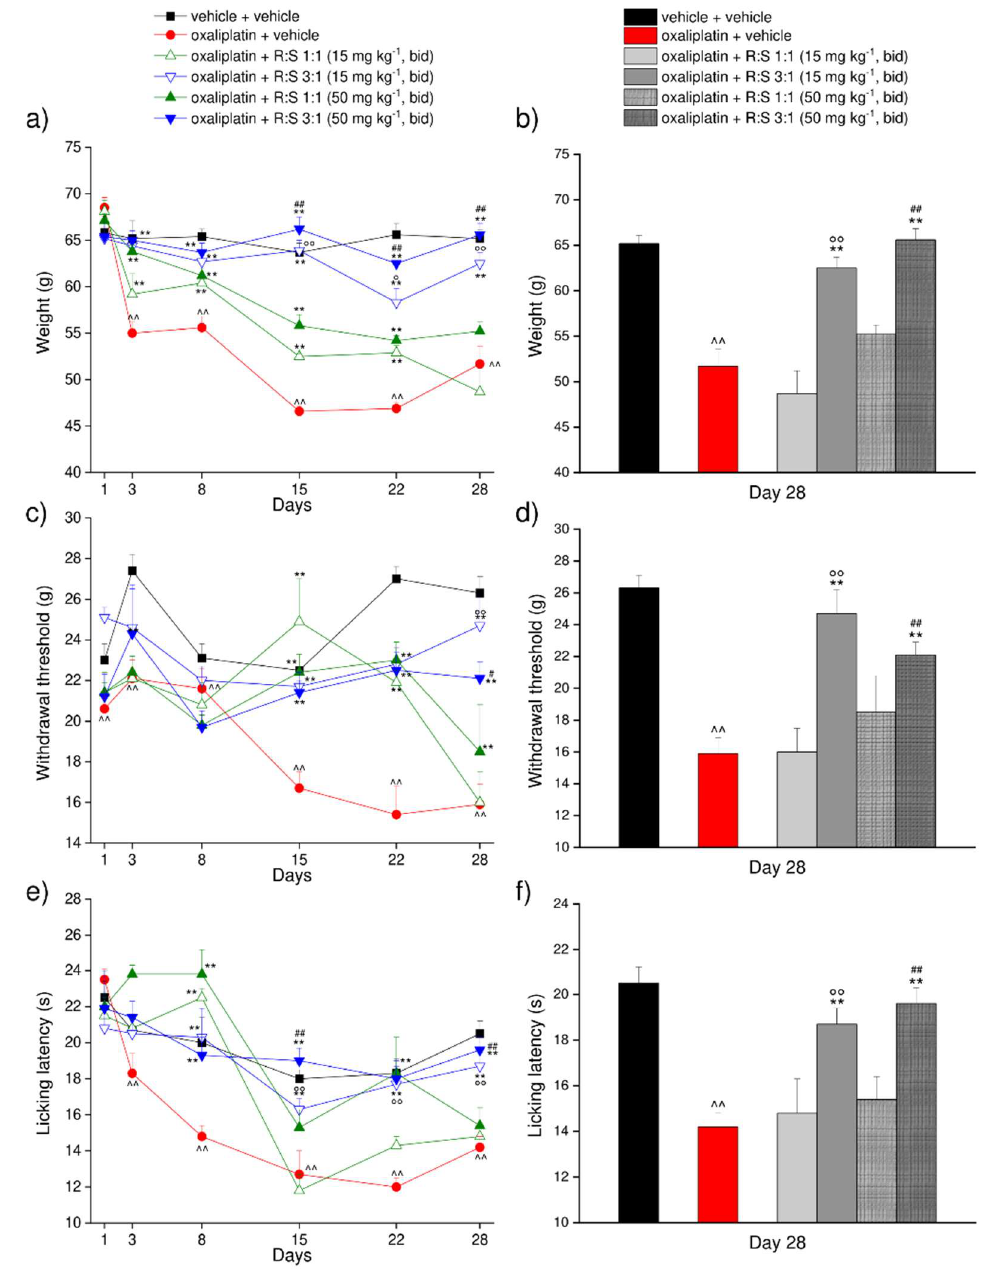
Figure 4. Evaluation of the effects of R:S 1:1 and R:S 3:1 against oxaliplatin-induced neuropathic pain. Oxaliplatin (2.4 mg kg −1 i.p.) was administered on days 1–15, for a total of 11 injections. R:S 1:1 and R:S 3:1 mixtures were dissolved in 1% CMC and were daily per os administered from day 1 until day 22 (15 and 50 mg kg −1 bid, in the morning and in the evening). Control animals were treated with vehicles. Behavioral measurements were performed before the daily injection of oxaliplatin or oral compounds. The pain-relieving effects of R:S 1:1 and R:S 3:1 was assessed by ( a ) Paw pressure test, ( c ) von Frey test and ( e ) Cold plate during treatment at the indicated time points, and ( b ) and ( d ) and ( f ) after 1 week of treatment wash-out (day 28, Paw pressure, von Frey and Cold plate tests, respectively). Each value represents the mean ± S.E.M. of 6 rats. Statistical analysis was one-way ANOVA followed by Bonferroni’s post-hoc comparison. ^^ p < 0.01 vs. vehicle + vehicle; * p < 0.05 and ** p < 0.01 vs. oxaliplatin + vehicle; ° p < 0.05 and °° p < 0.01 vs. oxaliplatin + R:S 1:1 15 mg kg −1 ; # p < 0.05 and ## p < 0.01 vs. oxaliplatin + R:S 1:1 50 mg kg −1 -treated animals.